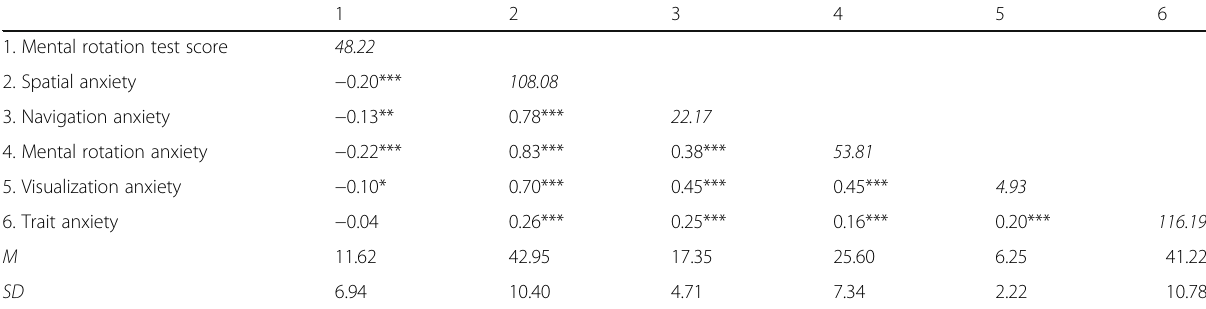
Table 3 Pearson correlation with mental rotations score, spatial anxiety, navigation anxiety, mental rotation anxiety, and trait